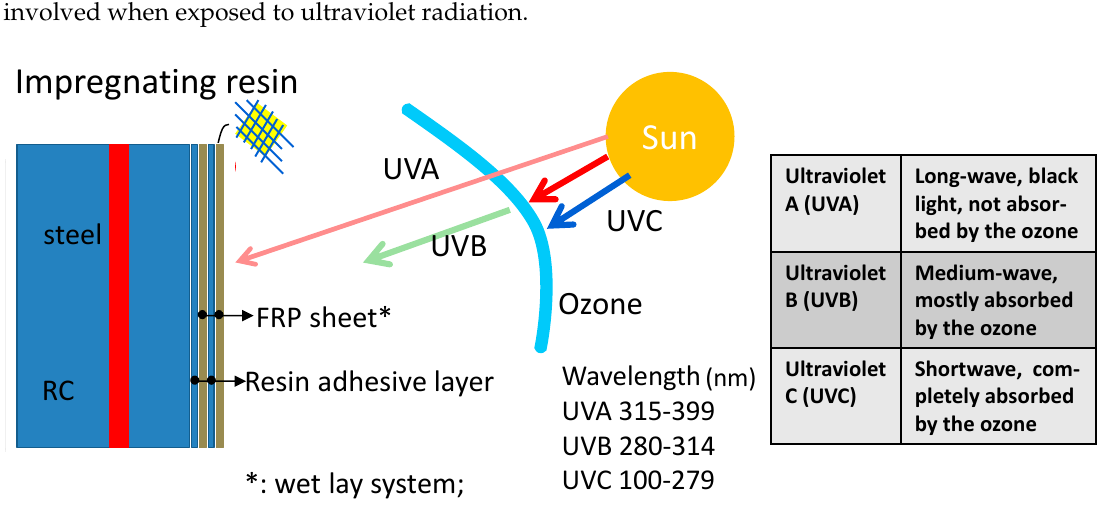
Figure 1. Potential effects on fibre reinforced polymer (FRP)-strengthened reinforced concrete (RC) structures from different UV lights.